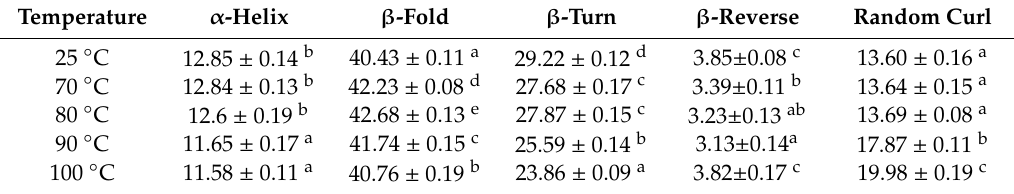
Table 5. The content of the secondary structure of lectin at different temperature.